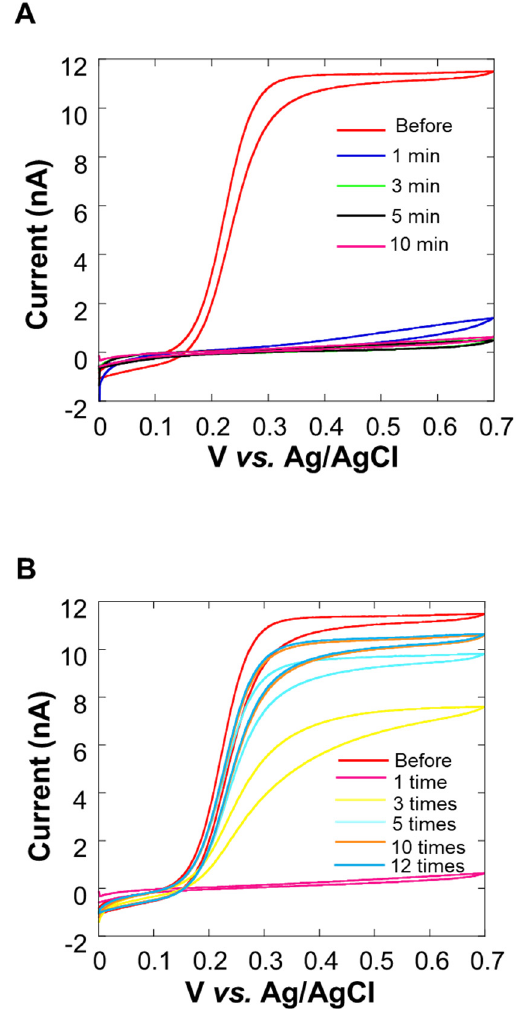
Figure 4. Cyclic voltammogram of 0.0~0.7 V vs. Ag/AgCl in potassium ferrocyanide solution at 0 min, 1 min, 3 min, 5 min, and 10 min after the measurement of the Pt microelectrode. Oxygen reduction current was measured at a sample-electrode distance of 20 µ m.